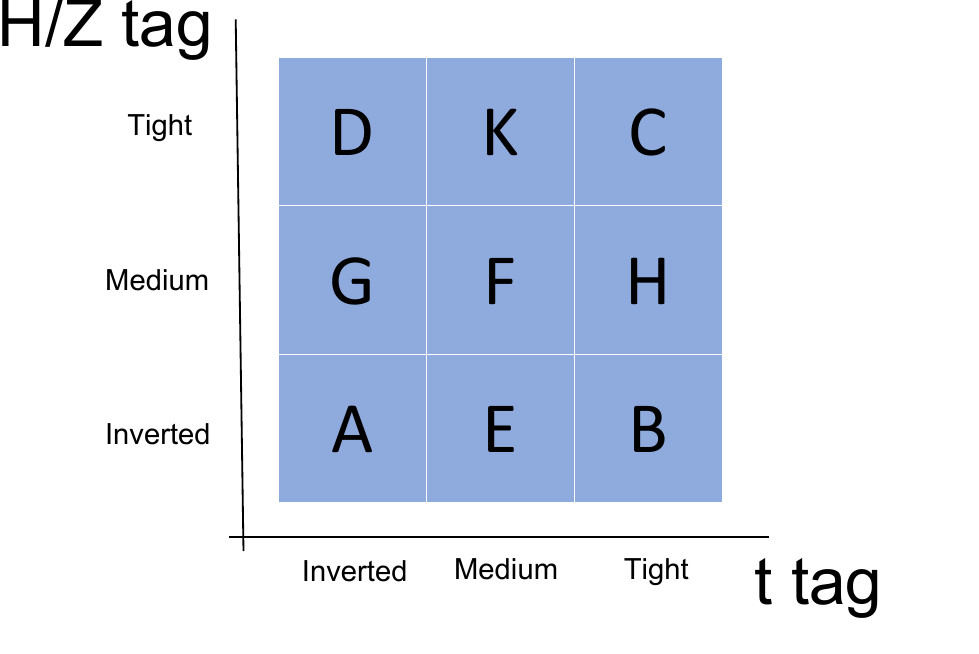
Figure 4 . Diagram showing the regions used for background estimation. The signal region is C, the regions A and B are used to determine TF( p , η ) , and F, K, and H are validation regions. The T x axis indicates the t tag category, and the y axis represents the Higgs or Z boson tag category. The inverted, medium, and tight tag category definitions are given in table